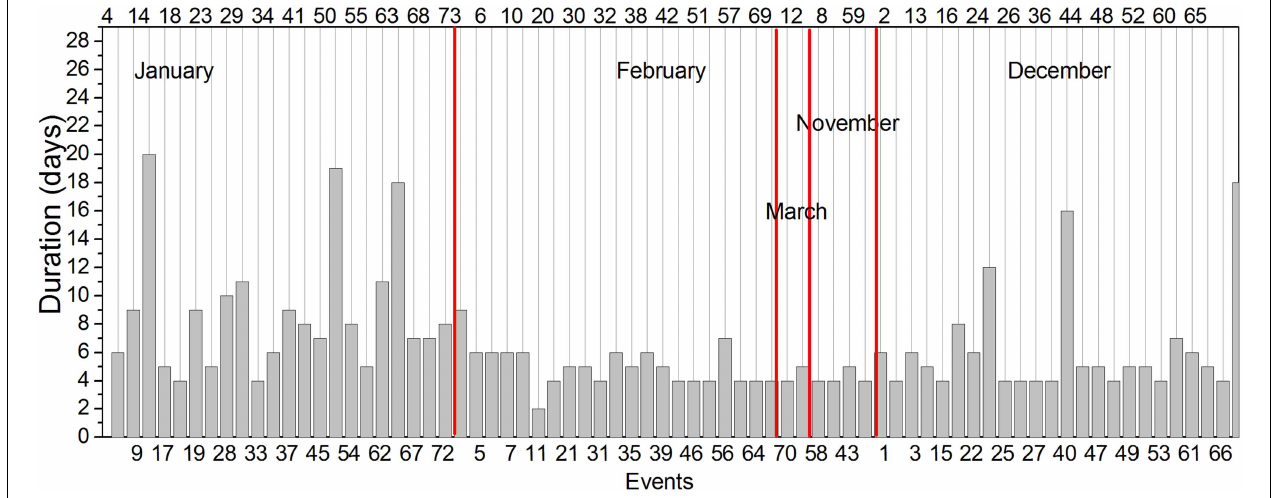
FIGURE 10 | Duration (in days) of every SACZ event simulated for the FUT